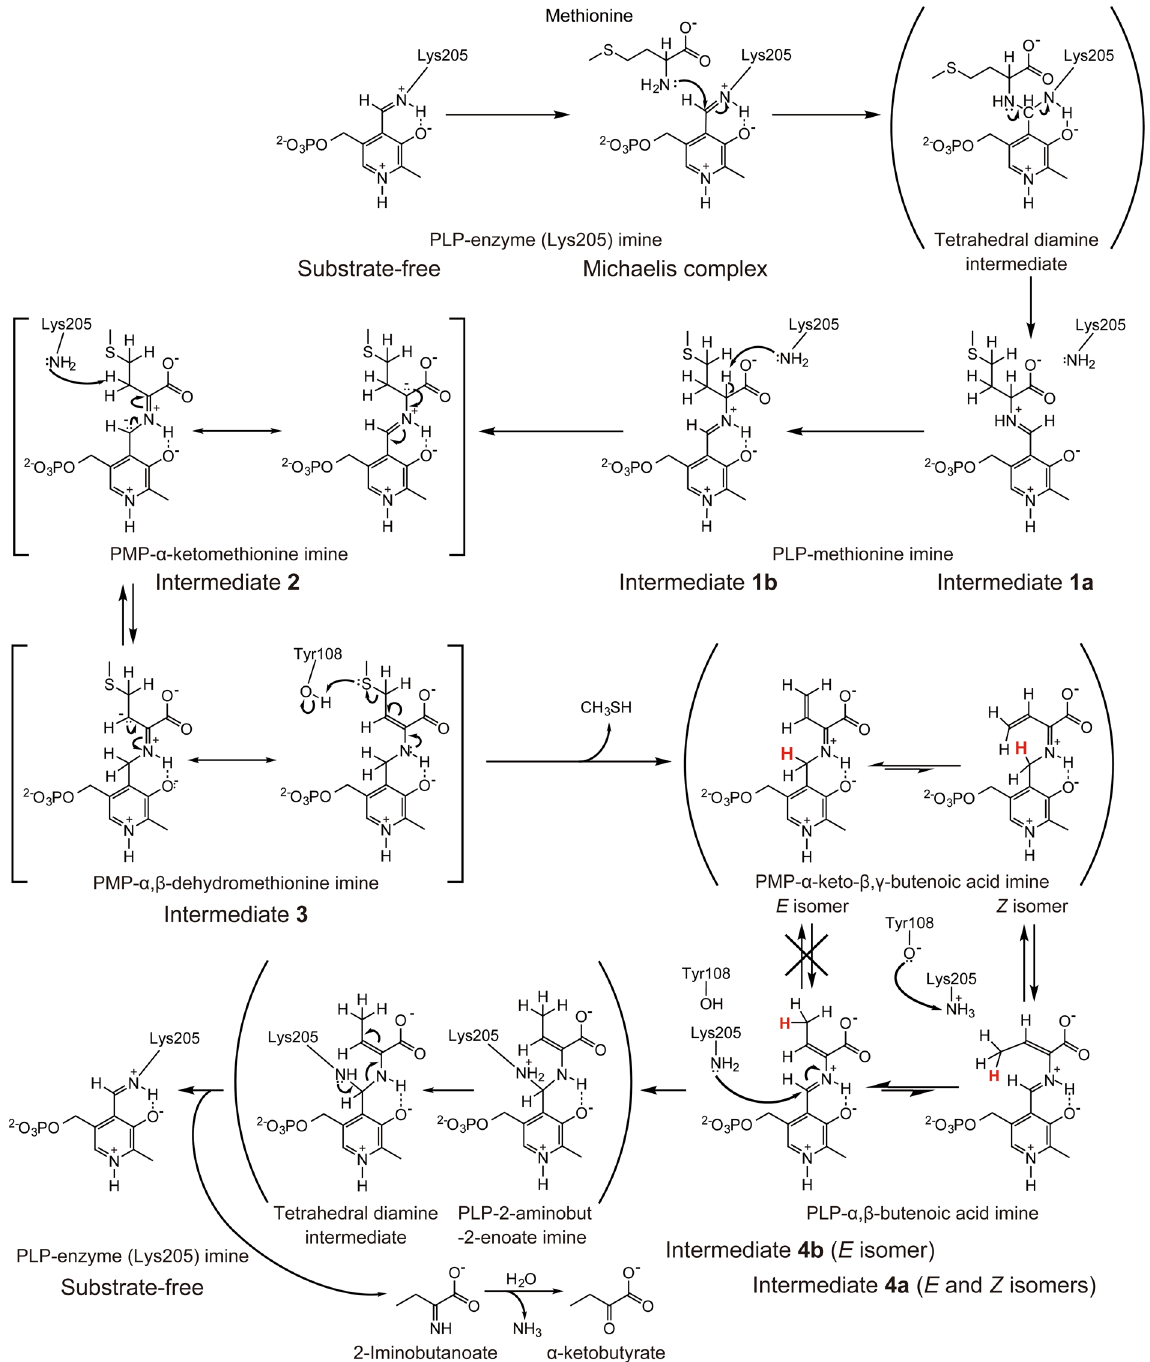
Figure 3. Proposed catalytic reaction mechanism of MGL. Intermediates in parentheses are transient and intermediates in brackets are resonance hybrids. The hydrogen atom involved in suprafacial [1,5]-sigmatropy is shown as red. PLP and PMP denote pyridoxal 5 ′ -phosphate and pyridoxamine 5 ′ -phosphate,